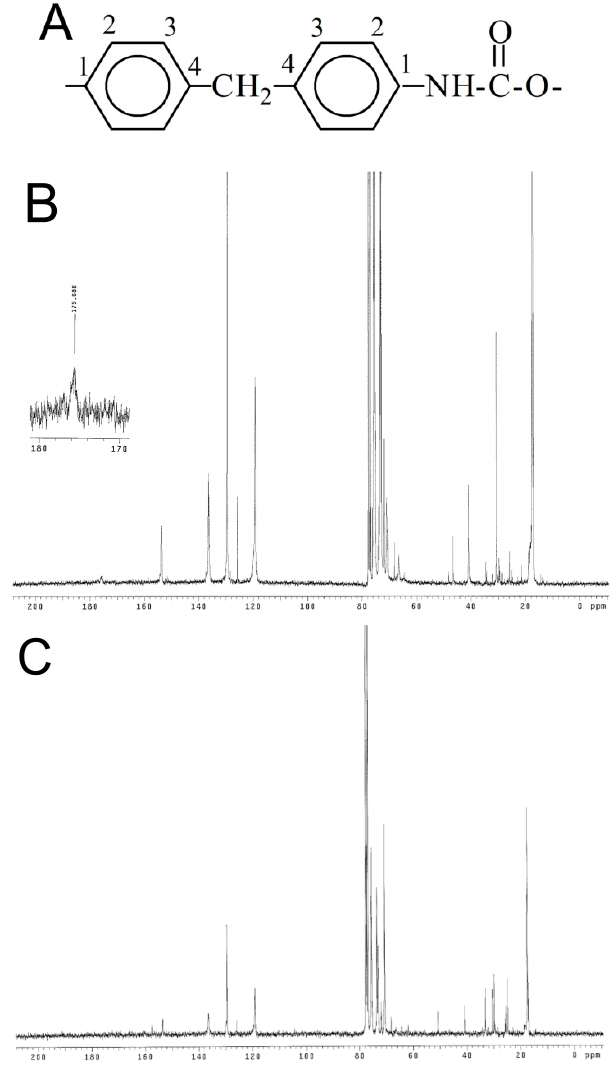
Figure 2. Numeration of methylene bis ‐ phenyl ‐ diisocyanate (MDI) carbons in PEUA ( A ); 13 C ‐